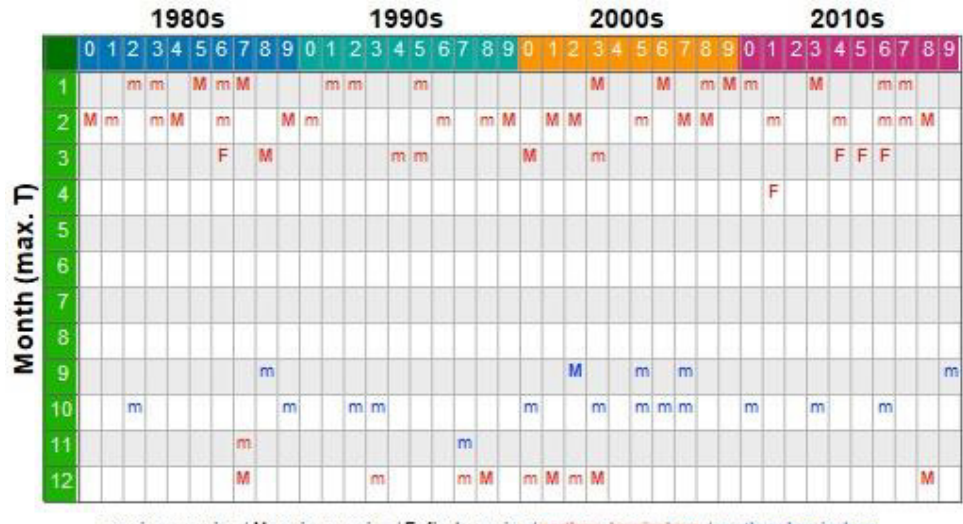
Figure 11. Occurrence of the SSW on the NH and SH. Capital letter means major SSW according to WMO definition.